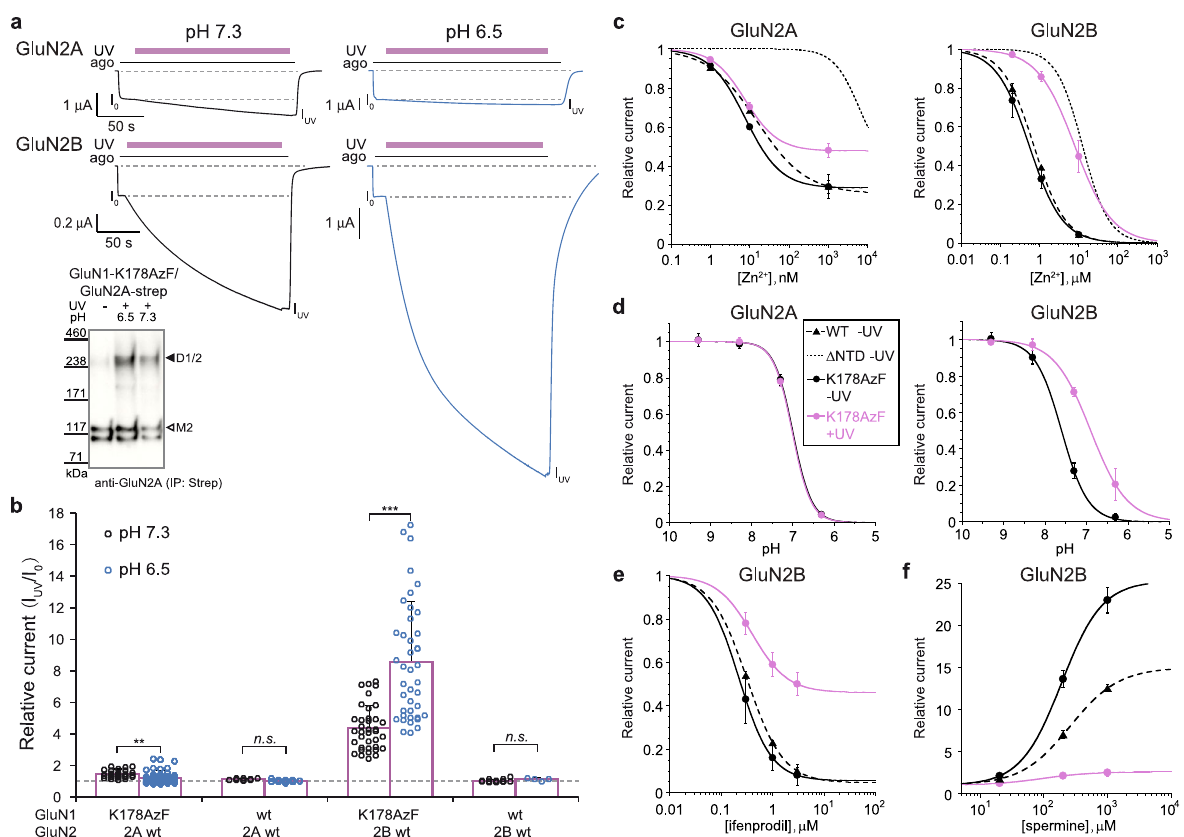
Fig. 3 Photocrosslinking differentially affects allosteric modulation of GluN2A and GluN2B receptors. a Representative current traces from oocytes expressing GluN1-K178AzF/GluN2A receptors (top traces) and GluN1-K178/GluN2B receptors (bottom traces) during UV illumination. Experiments were performed at pH 7.3 (left, black) or pH 6.5 (right, blue). ago, for agonists. Inset: immunoblots from HEK cells expressing GluN1-K178AzF/GluN2A-Strep mutant receptors and exposed to UV ( + ) or not ( − ) at pH 6.5 or 7.3. GluN2A-Strep monomer (M2) is expected to run at ~130 kDa, and GluN1/GluN2A heterodimer (D1/2) at ~240 kDa. b Change in current amplitude upon UV illumination (I uv /I o ) of wild-type (wt) receptors and GluN1-K178AzF/GluN2A and GluN1-K178azF/GluN2B mutant receptors, recorded either at pH 7.3 or 6.5. Values are, from left to right: 1.45 ± 0.23 ( n = 32) and 1.23 ± 0.37 ( n = 58) for AzF mutant GluN2A receptors; 1.09 ± 0.10 ( n = 10) and 1.04 ± 0.07 ( n = 12) for wt GluN2A receptors; 4.39 ± 1.40 ( n = 37) and 8.59 ± 3.71 ( n = 41) for AzF mutant GluN2B receptors; 1.04 ± 0.09 ( n = 16) and 1.14 ± 0.09 ( n = 4) for wt GluN2B receptors. Data represent mean ± SD. n = number of biologically independent cells. ** P = 0.004, *** P < 0.001, n.s. non-signi fi cant ( P = 0.22 for wt GluN2A and 0.06 for wt GluN2B) (one-way ANOVA). c Zinc sensitivity of GluN1-K178AzF/GluN2A receptors (left) and GluN1-K178/GluN2B receptors (right), before (plain black line) and after (violet) UV treatment. Dashed line, wt receptors; dotted line, GluN2- Δ NTD receptors 80 . Values of Zn 2 + IC 50 , maximal inhibition (for GluN2A receptors) and Hill slope (n H ) are: 7.43 ± 1.10 nM, 0.70 ± 0.03 and 0.99 ± 0.09 ( n = 4) before UV, and 7.69 ± 0.17 nM, 0.52 ± 0.04 and 1.05 ± 0.07 ( n = 3) after UV for GluN1-K178AzF/GluN2A; 15.33 ± 2.99 nM, 0.74 ± 0.05 and 0.70 ± 0.03 ( n = 4) for wt GluN1/GluN2A; 0.54± 0.01 μ M and 1.02 ± 0.02 ( n = 4) before UV, and 7.96 ± 0.16 µ M and 0.91 ± 0.02 ( n = 3) after UV for GluN1-K178AzF/GluN2B; 0.72 ± 0.03 μ M and 1.08 ± 0.04 ( n = 4) for wt GluN1/GluN2B. Data represent mean ± SD. n = number of biologically independent cells. d Proton sensitivity. Conditions as in c. Values of pH IC50 and Hill slope (n H ) are: 7.00 ± 0.02 and 1.91 ± 0.11 ( n = 9) before UV, and 7.01 ± 0.01 and 1.93 ± 0.07 ( n = 10) after UV for GluN1-K178AzF/GluN2A; 7.60 ± 0.01 and 1.37 ± 0.05 ( n = 7 – 9) before UV; and 6.90 ± 0.02 and 0.99 ± 0.03 ( n = 5 – 6) after UV for GluN1-K178AzF/GluN2B. Data represent mean ± SD. n = number of biologically independent cells. e Ifenprodil sensitivity of GluN1-K178AzF/GluN2B receptors before (plain black line) and after (violet) UV treatment. Dashed line, wt GluN1/GluN2B receptors. Values of ifenprodil IC 50 , maximal inhibition and Hill slope (n H ) are: 0.32 ± 0.02 µ M, 0.95 ± 0.02 and 1.22 ± 0.04 ( n = 3) for wt; 0.24 ± 0.06 µ M, 0.98 ± 0.09 and 1.25 ± 0.39 ( n = 4) before UV; and 0.40 ± 0.12 µ M, 0.54 ± 0.06 and 1.25 ± 0.11 ( n = 4) after UV for GluN1-K178AzF/GluN2B. Data represent mean ± SD. n = number of biologically independent cells. f Spermine sensitivity. Conditions as in e. Values of spermine EC 50 , maximal potentiation and n H are: 174.3 ± 64.5 μ M, 11.2 ± 3.3 and 1.26 ± 0.09 ( n = 3 – 5) for wt; 214.9 ± 63.2 μ M, 26.1 ± 2.5 and 1.29 ± 0.22 ( n = 4) before UV; and 93.0 ± 22.8 μ M, 1.6 ± 0.5 and 1.14 ± 0.16 ( n = 5) after UV for GluN1-K178AzF/GluN2B. Data represent mean ± SD. n = number of biologically independent